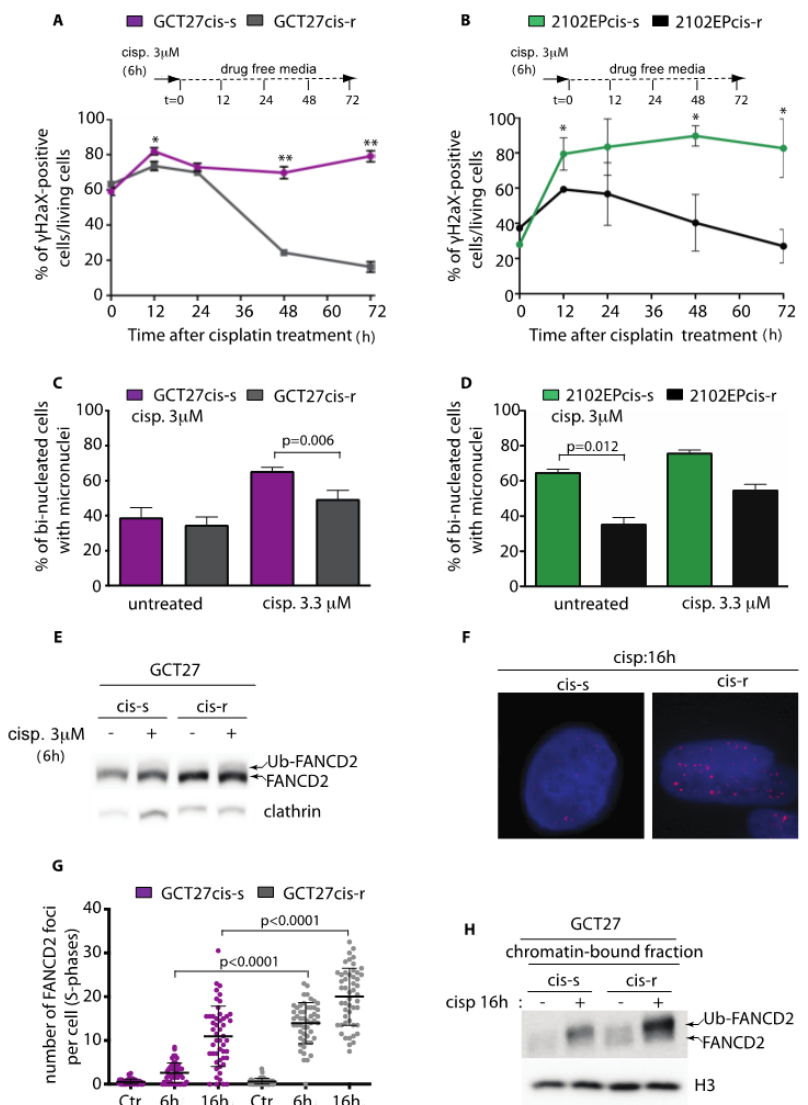
Figure 1 Figure 1. ( A , B ) Flow cytometry of γ H2AX-positive cells upon cisplatin treatment. Embryonal carcinoma (EC) cell lines were treated with a pulse of cisplatin for 6 h and collected for analysis at the indicated time points after drug washout. Data are mean values ± s.d. of three independent experiments. ( C , D ) Percentage of binucleated cells with one or more micronuclei in untreated and cisplatin-treated cells. Data are mean values ± s.d. of two independent experiments. ( E ) Western blotting analyses of FANCD2 expression in GCT27 paired cell lines before and after treatment with 3 µ M cisplatin for 6 h. Arrows point to the active monoubiquitinated (Ub-FANCD2) and inactive non-monoubiquitinated (FANCD2) forms of the protein. Clathrin was used as a loading control. Original blots see Figure S3A ( F ) Immunofluorescence of FANCD2 (red) in GCT27 cells collected at the indicated time point after drug washout. Cells were counterstained with Hoechst (blue) to identify nuclei. ( G ) Quantification of FANCD2 foci in GCT27 paired cell lines after a 6 h pulse with 3 µ M cisplatin. Foci were counted in S-phase (BrdU-positive) nuclei, both at the end of